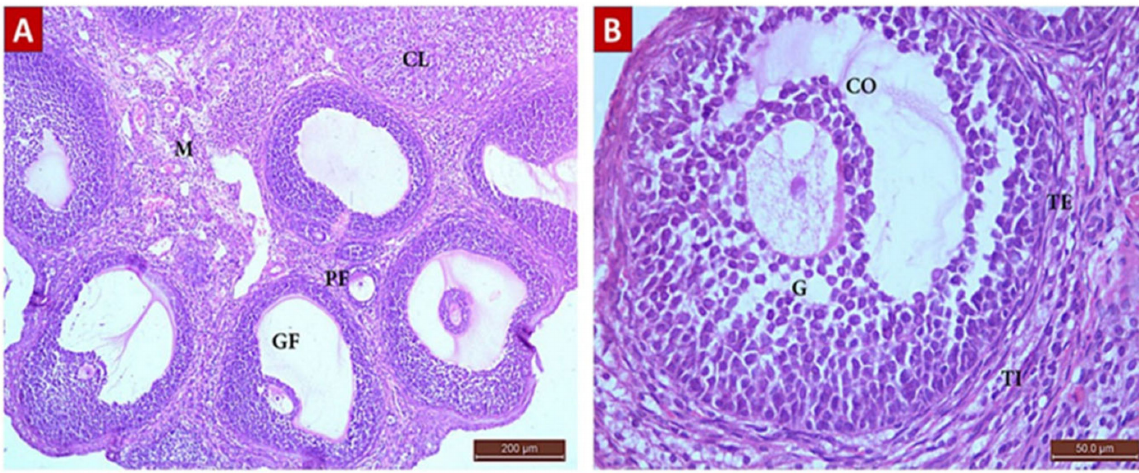
Figure 7. H&E photomicrograph from G IV group showing ovarian architecture comparable to control (G I) group, a remarkable improvement from that shown in POI (G II) group. ( A ) Ovarian section from G IV group rat at x100 magnification showing the ovarian cortex with follicles in different stages of development, primary follicles (PF), multiple Graafian follicles (GF), and corpus luteus (CL) comparable to control (G I) group. Normal medulla (M) is visible. ( B ) Ovarian section from G III group rat at x400 magnification showing a normal GF comprising an antrum, cumulus oophorus (CO), oocyte, and a single fluid cavity lined by granulosa (G) cells. The follicle is surrounded by normal layers of theca interna (TI) and theca externa (TE)